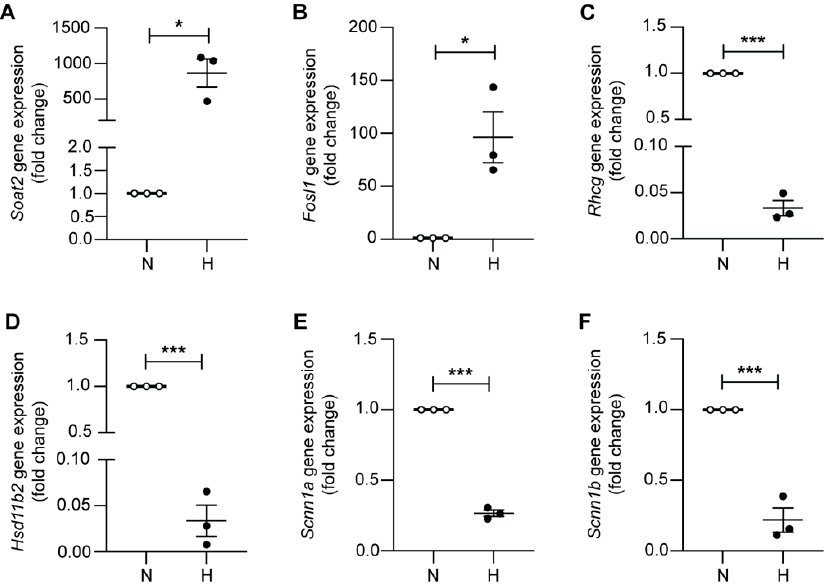
Figure 2 . RNAseq validation of differentially-regulated genes. Relative mRNA expression levels of ( A ) Soat2 , ( B ) Fosl1 , ( C ) Rhcg , ( D ) HSD11b2 , ( E ) Scnn1a ( α ENaC), and ( F ) Scnn1b ( β ENaC) in mCCD cl1 cells following 24 h of normoxia (N) or hypoxia (H) ( n = 3 per condition). * p < 0.05, *** p < 0.001.